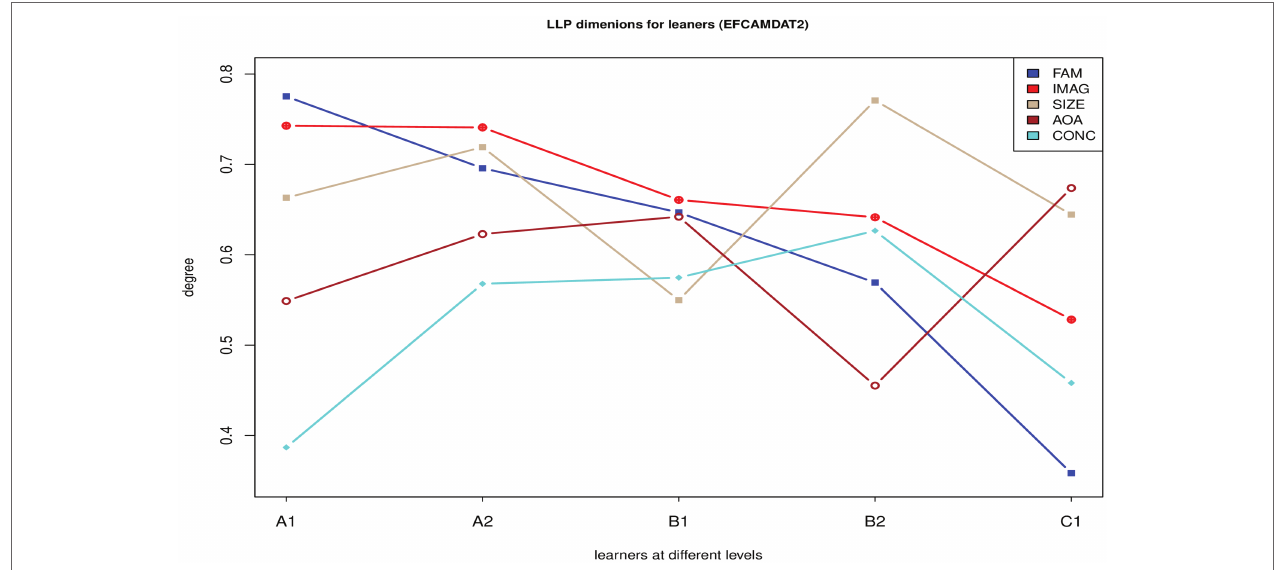
FIGURE 2 | LPP dimension scores of the five sub-corpora of the EFCAMDAT2. FAM, familiarity; IMAG, imageability; SIZE, semantic size; AoA, age of acquisition; CONC, concreteness.